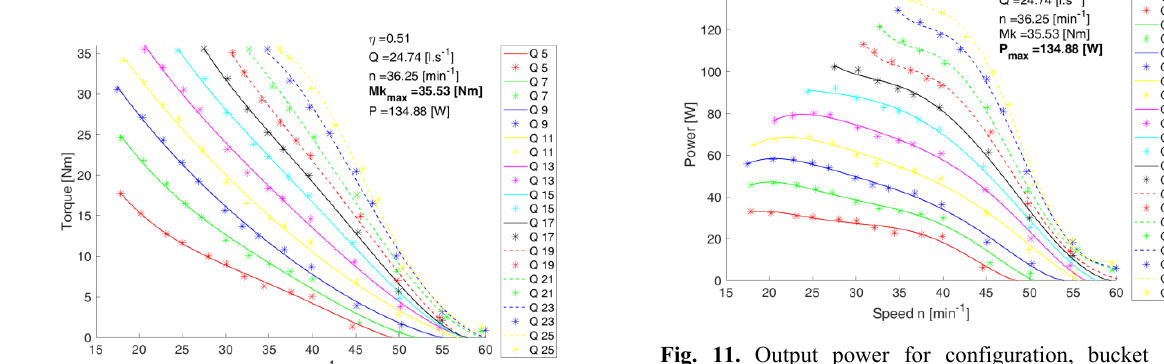
Fig. 11. Output power for configuration, bucket 00 and channel edge position -40 for different flow rates. Table 3. Basic parameters for maximal output power obtained at each